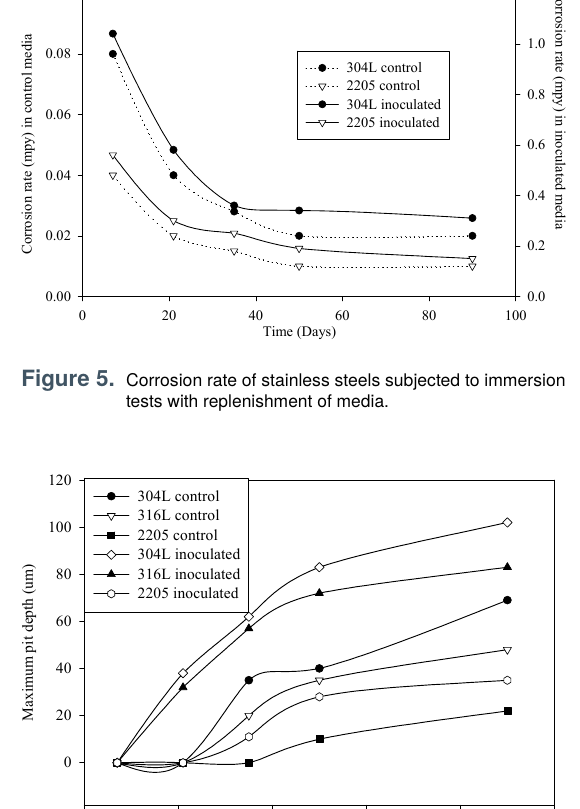
Figure 6. Maximum pit depth in case of stainless steels subjected to immersion tests with replenishment of media.